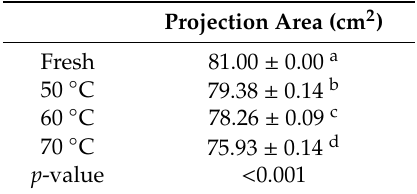
Table 3. Projection area changing of linden leaves under IR processing at di ff erent